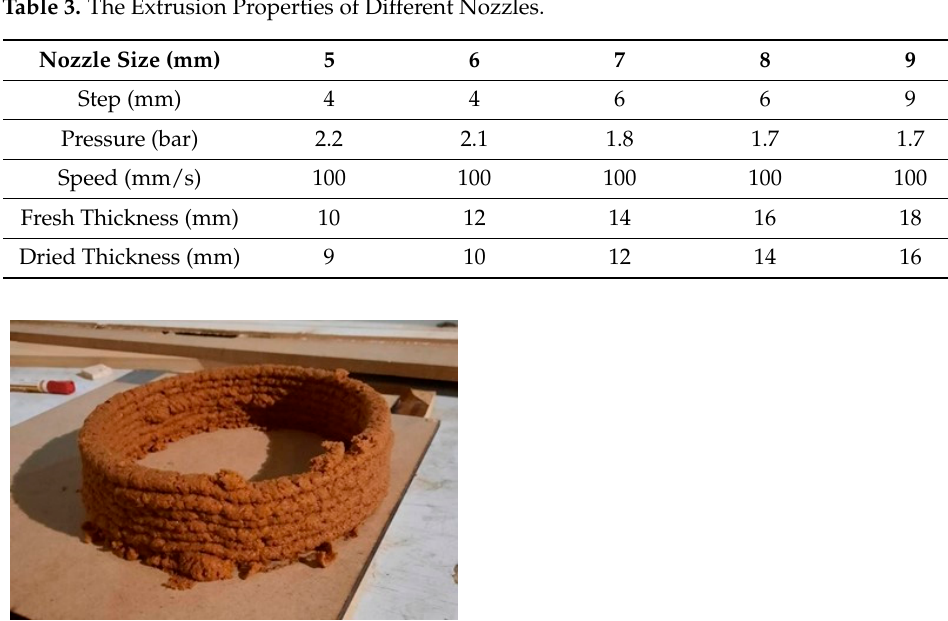
Table 3. The Extrusion Properties of Different Nozzles.